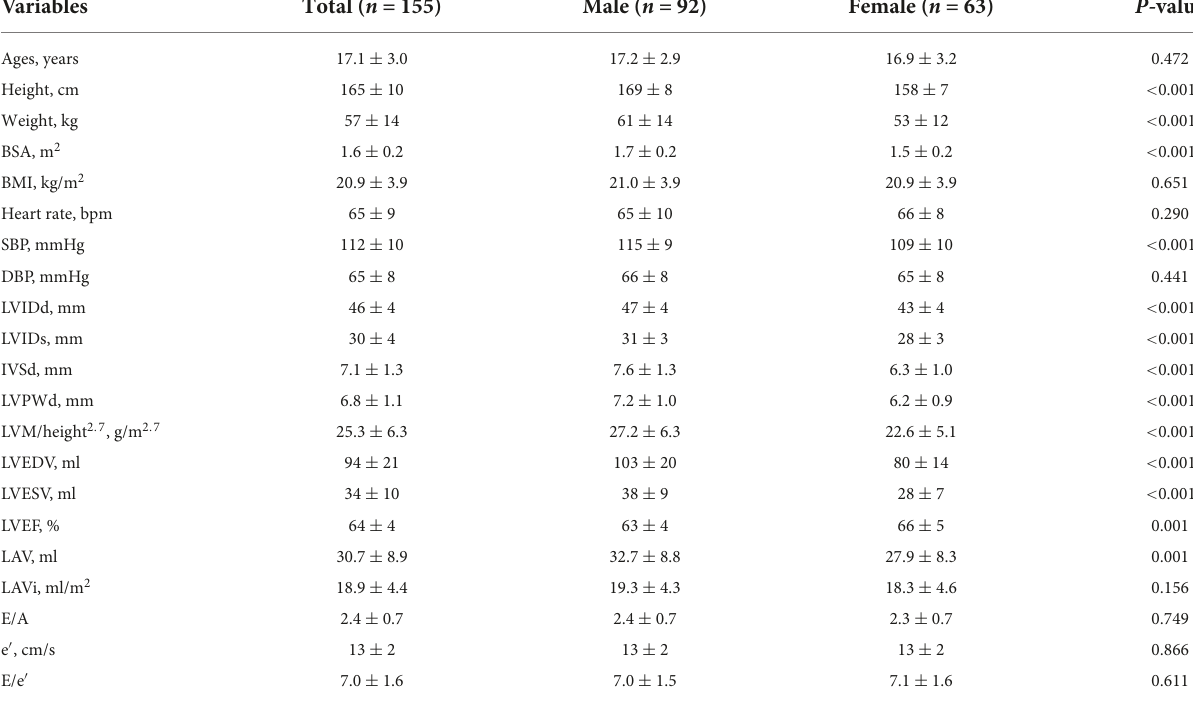
TABLE 1 Demographic and conventional echocardiographic characteristics in heathy young people between genders.